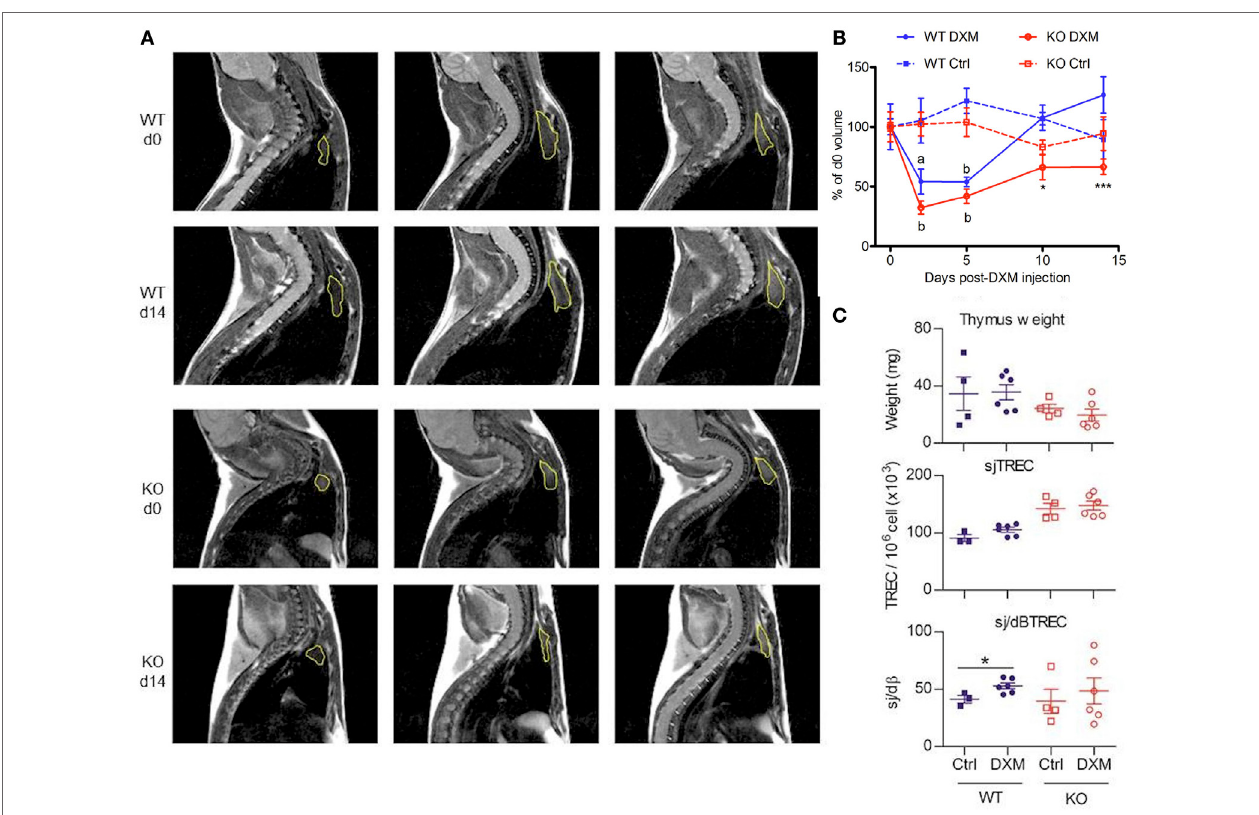
FigUre 4 | Follow-up of dexamethasone (DXM)-induced atrophy and recovery. (a) Representatives MRI slices showing thymus [region-of-interest (ROI), yellow] of wild-type (WT) and KO at d0 and d14 after DXM injection. Lines show three successive slices around the maximal ROI. (B) Evolution of thymic volumes normalized in% of d0 value is shown for WT (blue) and KO (red) mice treated with DXM (filled line, n = 6 per group) or control solution (dotted line, n = 4 per group). Paired t -test was used for effect of DXM vs d0. a p : < 0.05, b p < 0.01. Two-way ANOVA test (time and treatment) with Bonferroni post-test (WT vs KO for DXM or Ctrl treatment) was used for statistical analyze of genotype variation. * p < 0.05, *** p < 0.001. (c) Thymus weight, sjTREC and sj/d β ratio of WT (blue) and KO (red) mice at d15 post DXM- (circle, n = 6 per group) or control-injection (square, n = 4 per group). Unpaired t -test was used for statistical analysis. * p < 0.05. (B,c) Data (mean ± SEM) are representative of two independent